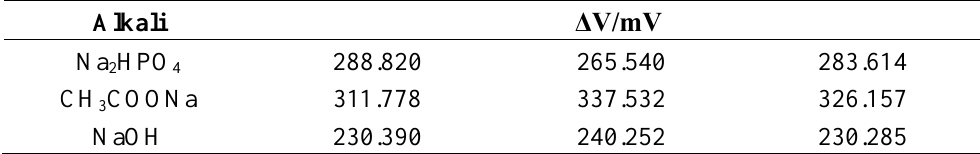
Table 1. Effect of alkali used on the response of the